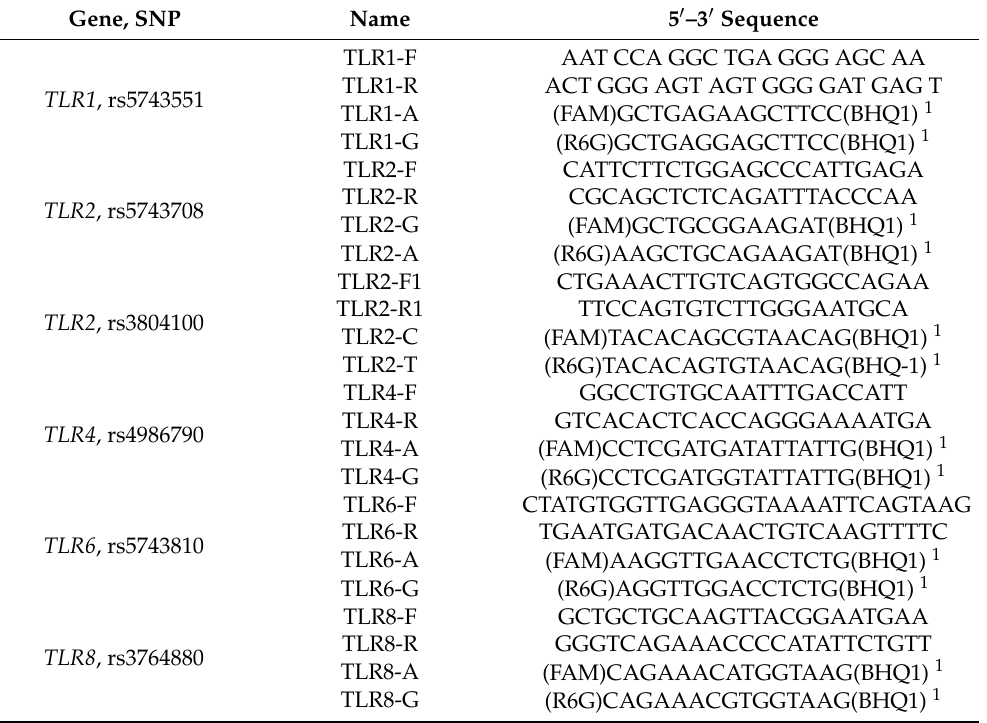
Table 2. Oligonucleotide